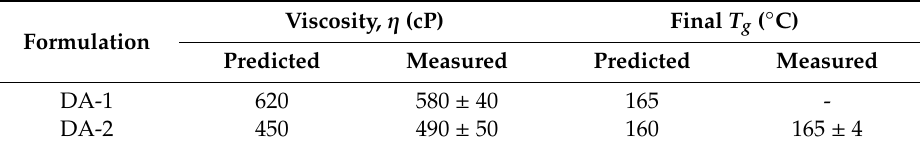
Table 4. The predicted and measured viscosities at 25 ◦ C and final T g s of the DA-1 and the DA-2 formulations.